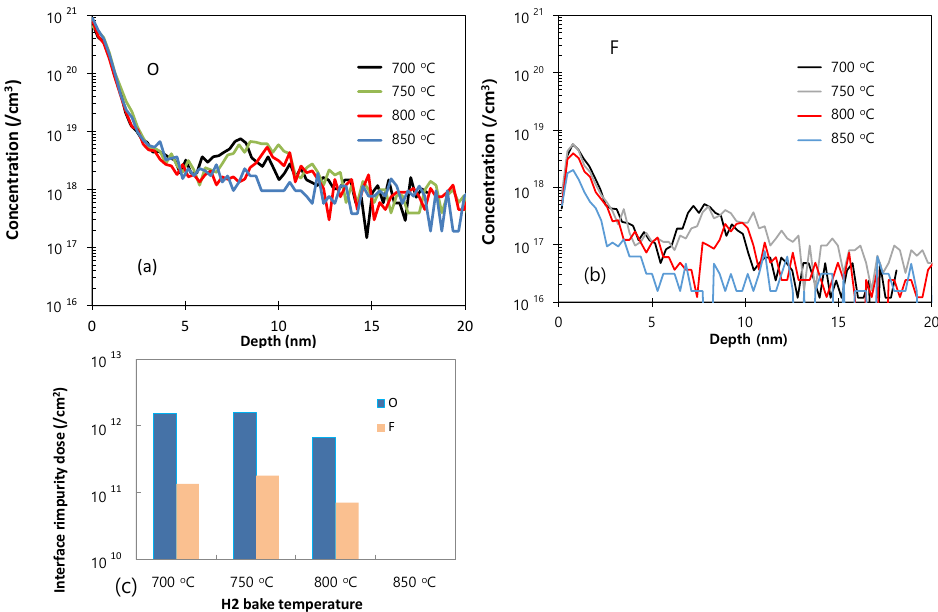
The interfaces between the substrate and the epitaxial layer are distinguished in 700, 750, 800 ◦ C—samples as SIMS results. In Figure 7, the HRTEM images showing atomic lattices and FFT diffraction patterns for the 750 ◦ C-sample show the crystalline structure of the Si-epitaxial layer. A multi-stack consisting of Si/SiGe/Si on Si substrate was also grown. Figure 8 shows the TEM images of Si cap (~10 nm)/SiGe (~14nm)/Si buffer (~5 nm) multi- stack layers grown on a Si substrate. That sample was grown after wet pre-cleaning (200:1 DHF) and subsequent H 2 bake at 700 ◦ C. HRXRD was measured to characterize the SiGe epi layer. It shows SiGe layer has a 32% Ge fraction and strained.